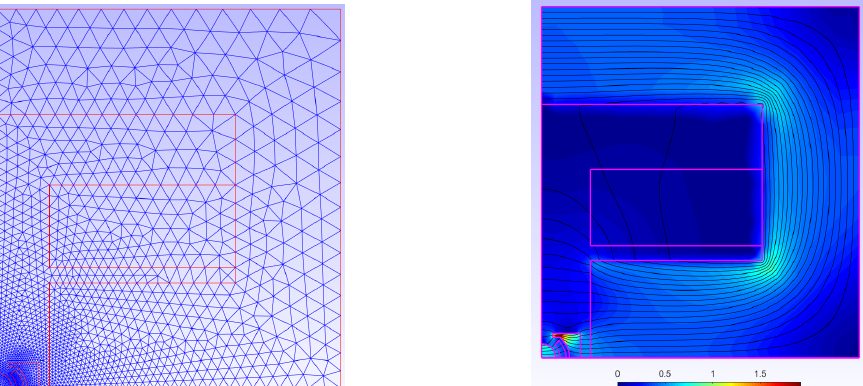
Figure 18. The mesh of studied domain ( left ); the flux density distribution in the studied do- main ( right ).